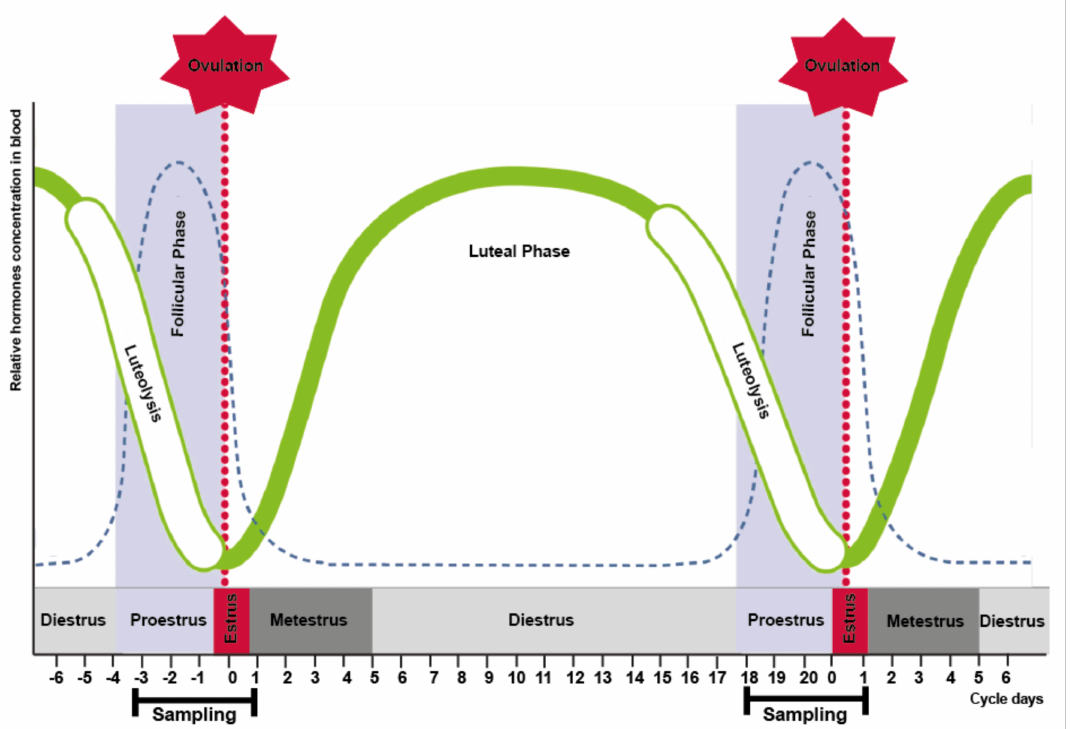
Figure 2. Sampling days according to phases of the bovine estrus cycle. Sampling started on day 18 of the reproductive cycle and finished at the day 1 of the following